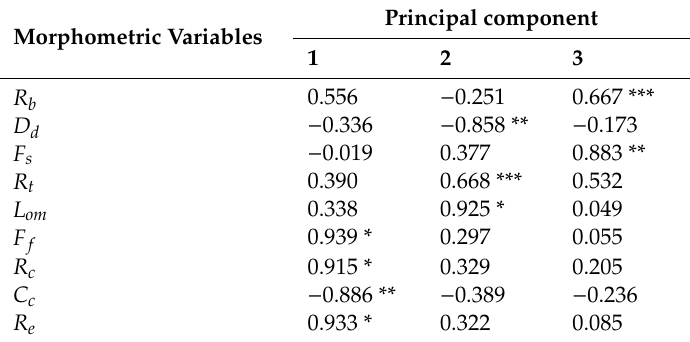
Table 10. Rotated factor-loading matrix of morphometric variables.